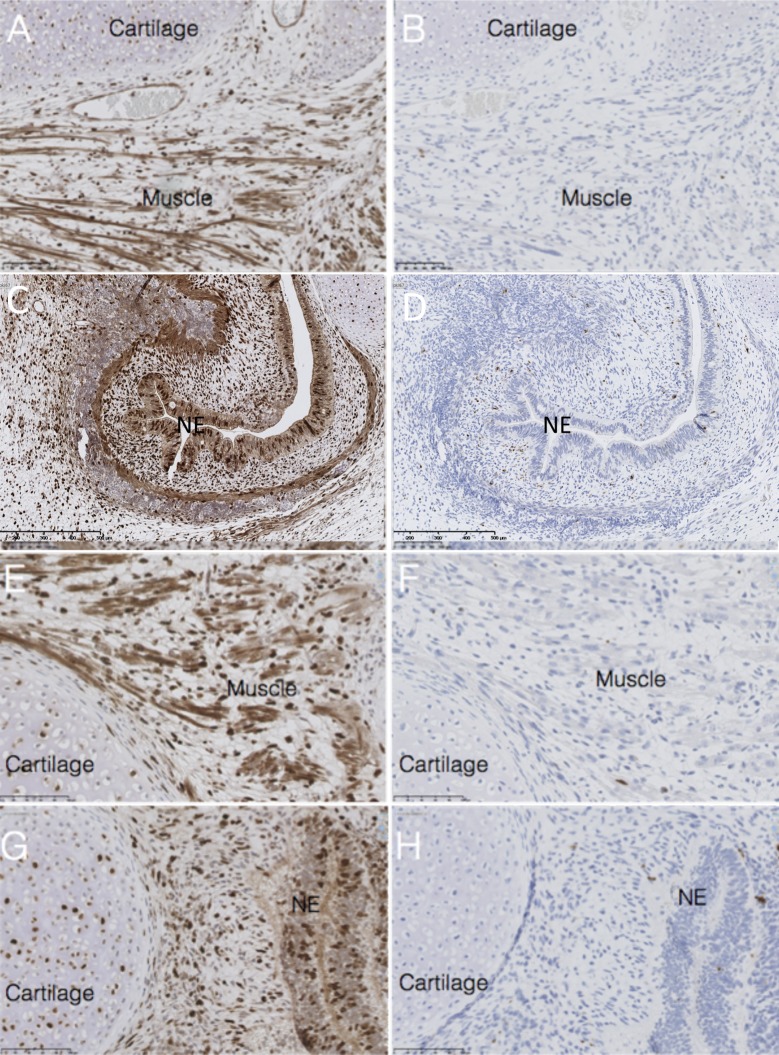
The effects of doxo on PSCT non-malignant embryonic tissues.Immunohistochemistry staining of formalin-fixed paraffin-embedded PSCT histological slides, following intra peritoneal injection of the host mouse with 8mg/kg doxo (A-D), or 4+4mg/kg doxo (E-H). High frequencies of positive staining for Ki67 in tissues compatible with neural epithelium, muscle and cartilage can be seen, indicative of extensive proliferation (A,C,E,G). Low frequencies of positive staining for cleaved caspase 3 can be seen in NE, muscle and cartilage, indicative of low frequencies of apoptosis (B,D,F,H). Size bars: 50μm.